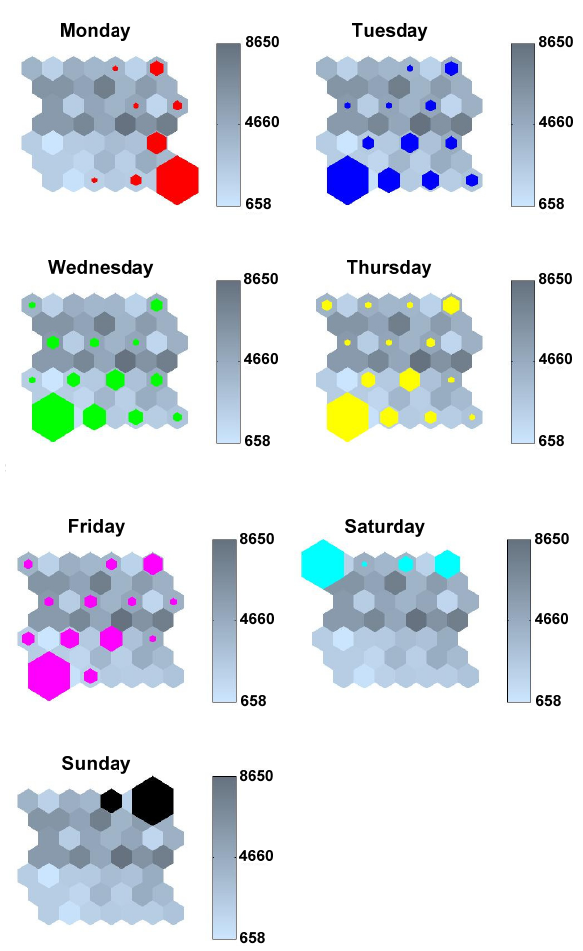
Figure 6. Activation map for weekdays.